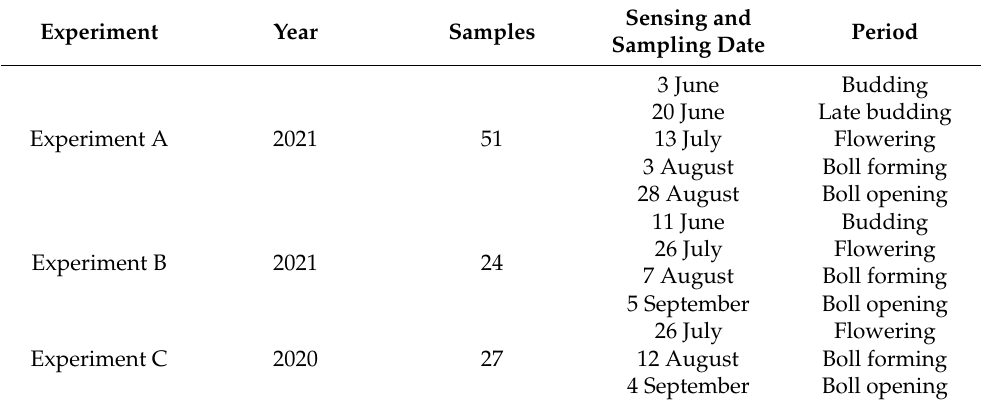
Table 1. Sampling date and corresponding growing seasons for the ground-measured leaf area index (LAI) and unmanned aerial vehicle (UAV) missions in three experiments.